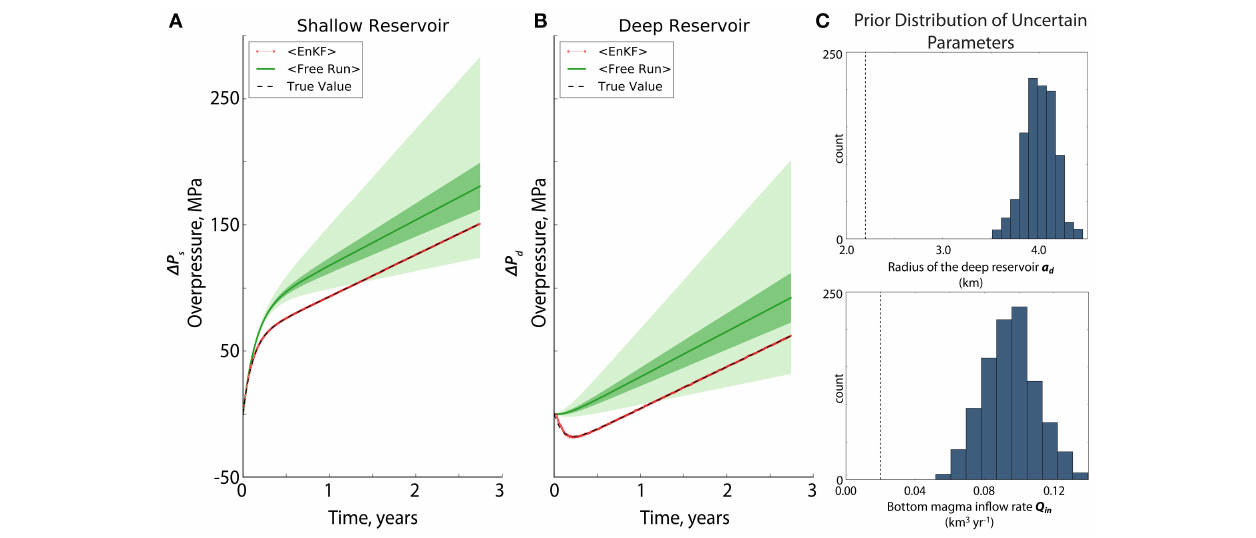
FIGURE 7 | The evolution of the overpressures after performing the state-parameter estimation (A,B) given that the prior distributions of the uncertain parameters (C) are Gaussian, not centered on their true values (black broken lines). In (A,B) the black broken line represents the true value of the overpressures; the green ones represent the result of the free run where the green solid line is the mean overpressure, the dark green fill is the spread (1 σ ) and the light green fill covers the full extent of the ensemble (i.e., [min, max]); the red ones represent the result of EnKF where the red solid line is the mean, the dark red fill is the spread (1 σ ) and the light red is the full extent of the ensemble. Notice that the spread of the ensemble is very narrow for the assimilation case.